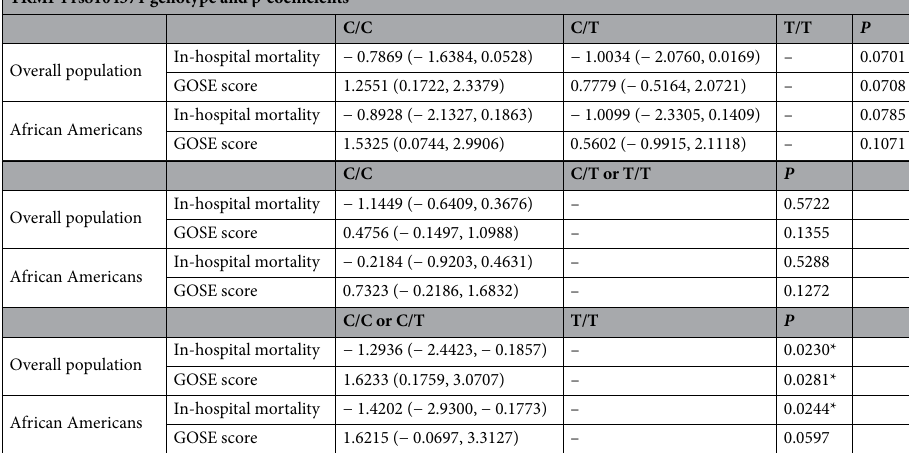
Table 6. TRMP4 rs8104571 genotype and outcome analysis utilizing multiple logistic and linear regression controlling for age, sex, injury severity score, and head abbreviated injury scale. C cytosine, T thymine, GOSE Glasgow outcome scale-extended, recorded on first follow-up visit. GOSE scores < 4, < 5, and > 6 could not be assessed by multiple logistic regression due to an absence of favorable outcomes among those with the T/T genotype resulting in unstable parameter estimates; *Significant P values < 0.05.